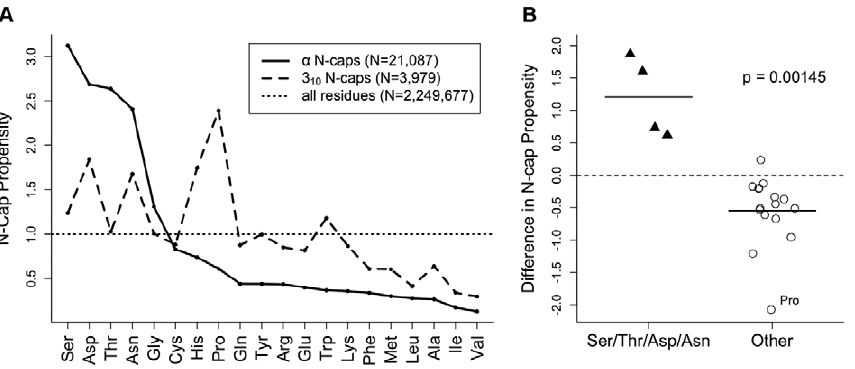
Figure 2. N-cap propensities vary by amino acid type. ( A ) The 20 amino acid types are shown ranked according to their a -helix N-cap propensity (solid line), defined as the fraction of a -helix N-cap residues of the given amino acid type, divided by the fraction of general case residues of that amino acid type (dotted line). The correlation with the analogously defined 3 10 -helix N-cap propensity (dashed line) is surprisingly weak, except for both slightly disfavoring hydrophobics. For example, Ser/Asp/Thr/Asn are the most common N-caps for a -helix but are not especially favored as N-caps for 3 10 -helix. Some other hydrophobic amino acids like Ala/Ile/Val are uncommon as either type of N-cap. ( B ) The canonical a -helix N-caps Ser/Thr/Asp/Asn (triangles) are grouped separately from the other 16 amino acid types (circles); the two groups are compared based on the difference between a -helix N-cap propensity and 3 10 -helix propensity. The horizontal dotted line at 0.0 indicates neither an increase nor a decrease in preference for a -helix N-caps instead of 3 10 -helix N-caps. A one-tailed Mann-Whitney test shows with 95% confidence (p-value=0.00145 , a =0.05) that Ser/Thr/Asp/Asn are statistically unique in terms of their specificity for a -helix N-caps.